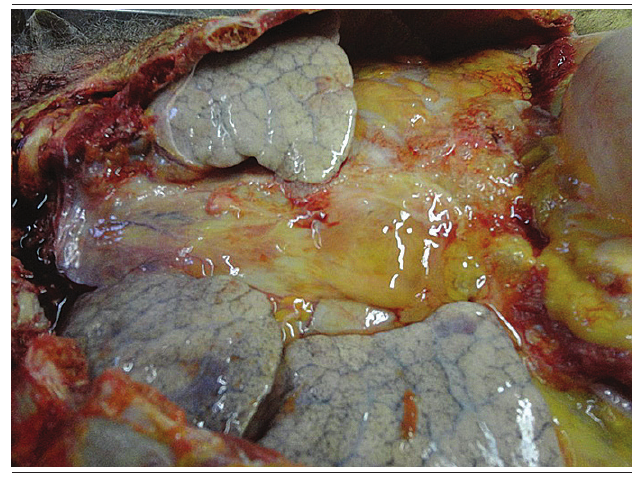
figurE 3 − Thoracic cavity evidencing